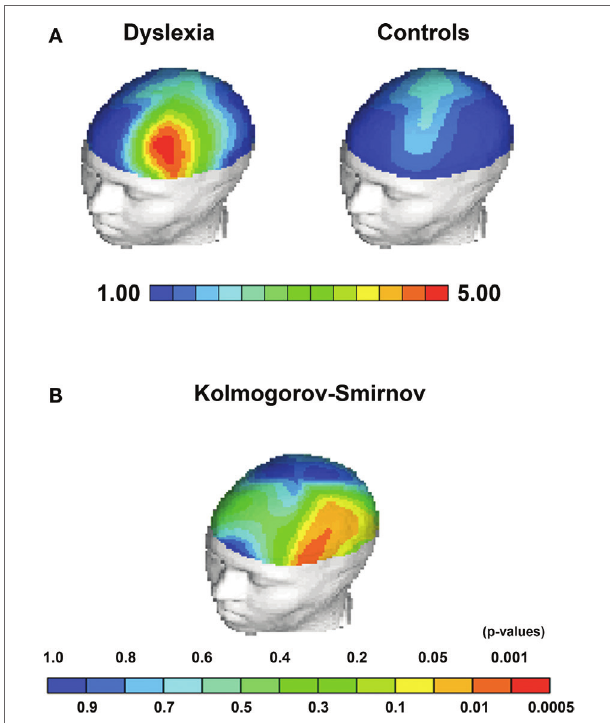
FigUre 2 | statistical topographical maps depicting group average differences and Ks-statistics for Theta eeg power . (a) Group average Theta power differences between children with dyslexia and controls localized to Broca’s area. (B) Kolmogorov–Smirnov between group statistic indicating significant topographical between group differences in Broca’s area, frontal regions, and the left